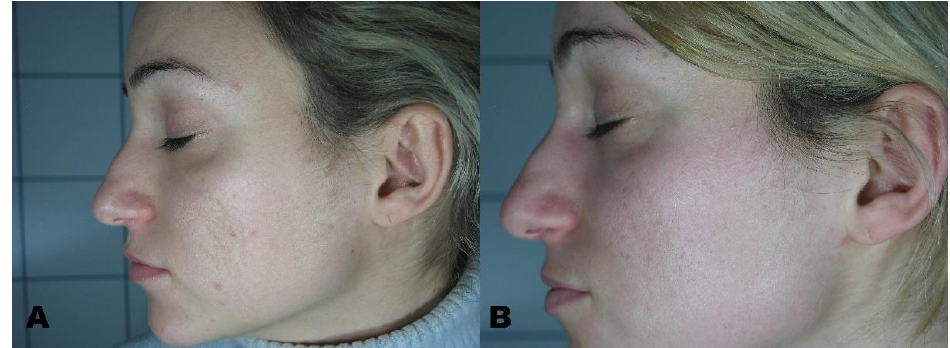
Figure 5. ( A ) Solar lentigo before treatment; ( B ) region three months after the last session.